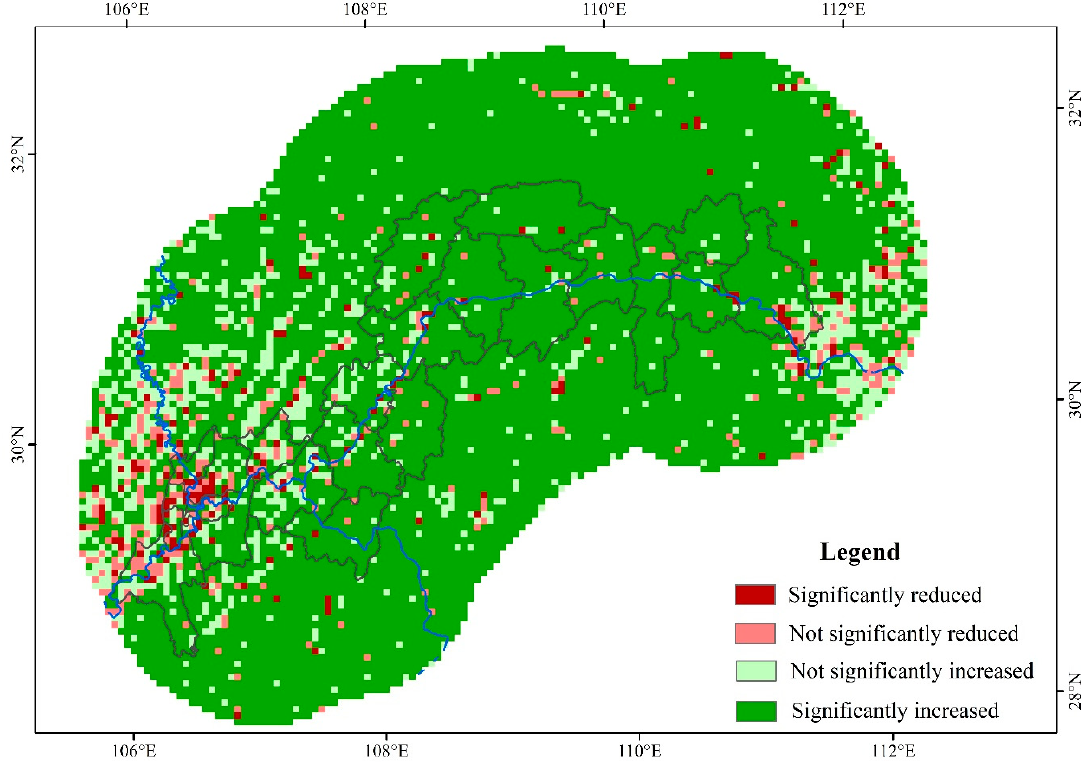
Figure 2. Trends of annual maximum NDVI from 1998 to 2018.